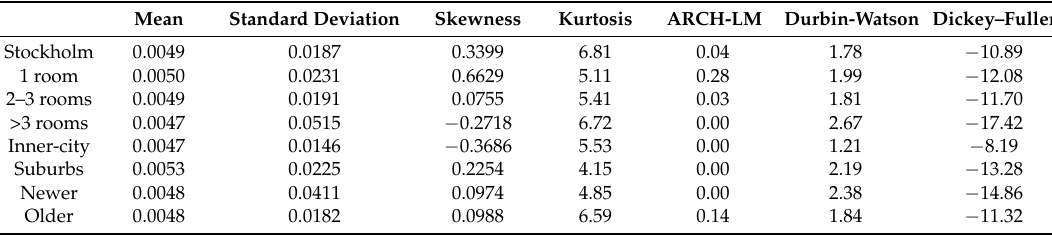
Table 3. The descriptive statistics: prices indices data.